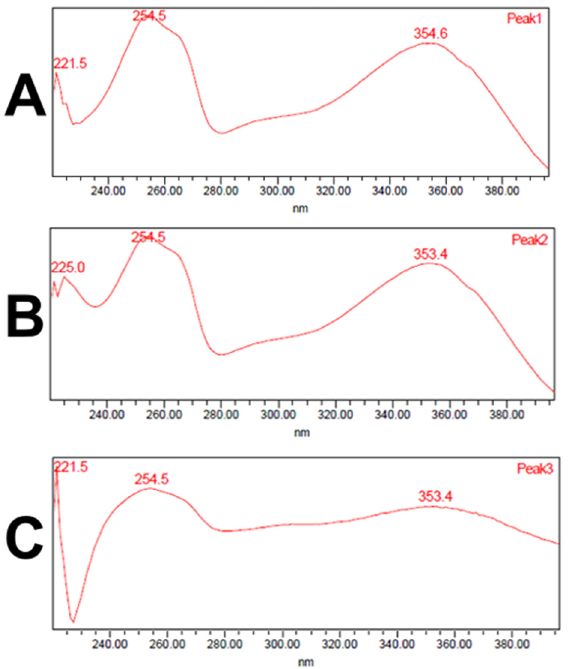
Figure 5. UV spectrum obtained from HPLC-DAD analysis of rutin ( A ), nicotiflorin ( B ), and nar- cissin ( C ).